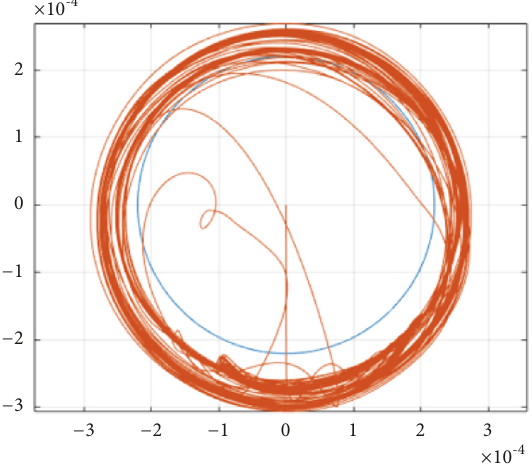
Figure 35: Predicted rotor DE node orbit.